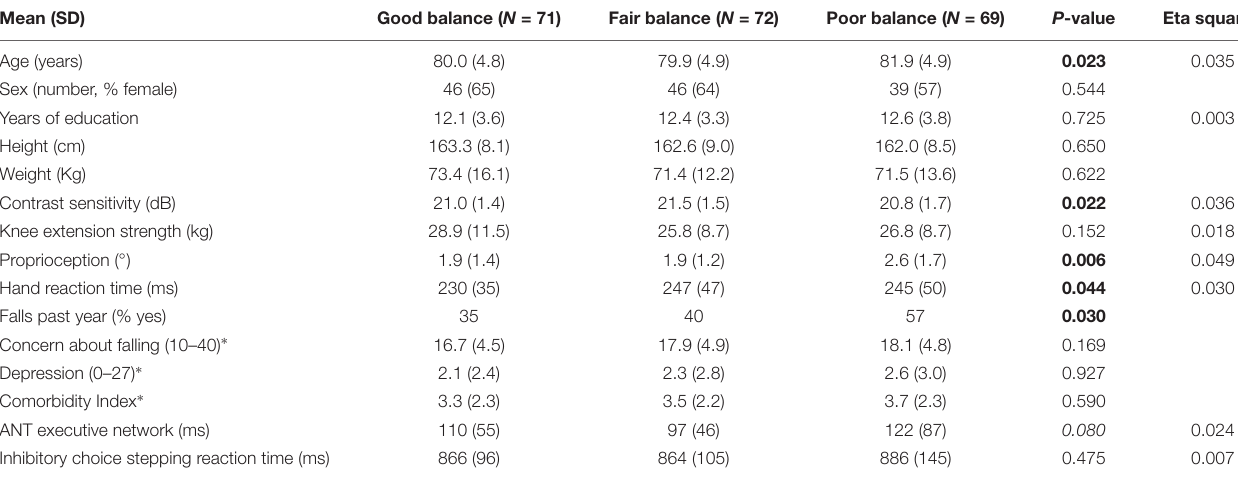
TABLE 1 | Demographics, health, psychological, sensory, and fall risk profile of participants stratified by balance